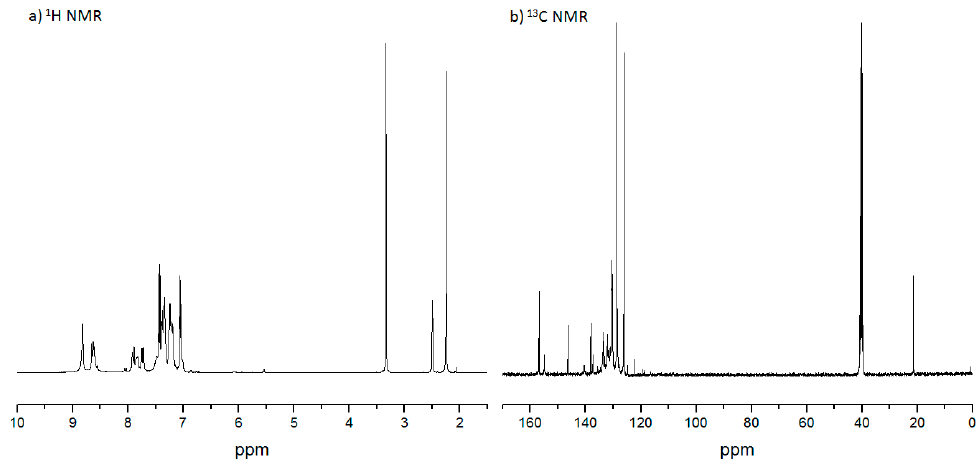
Figure 4. 1 H and 13 C NMR spectra of ionic polymer P-2 in d6- DMSO taken at room temperature.